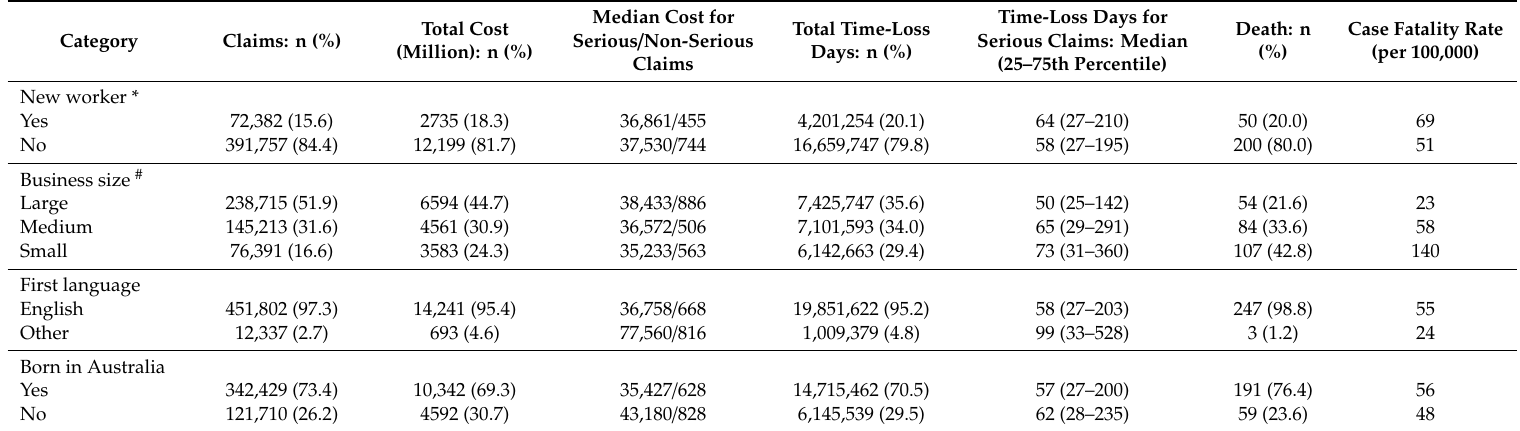
Table 5. Summary of claims, percentages, compensation costs, and time-loss days by new worker, business size, first language, birth place, and season in South Australia,